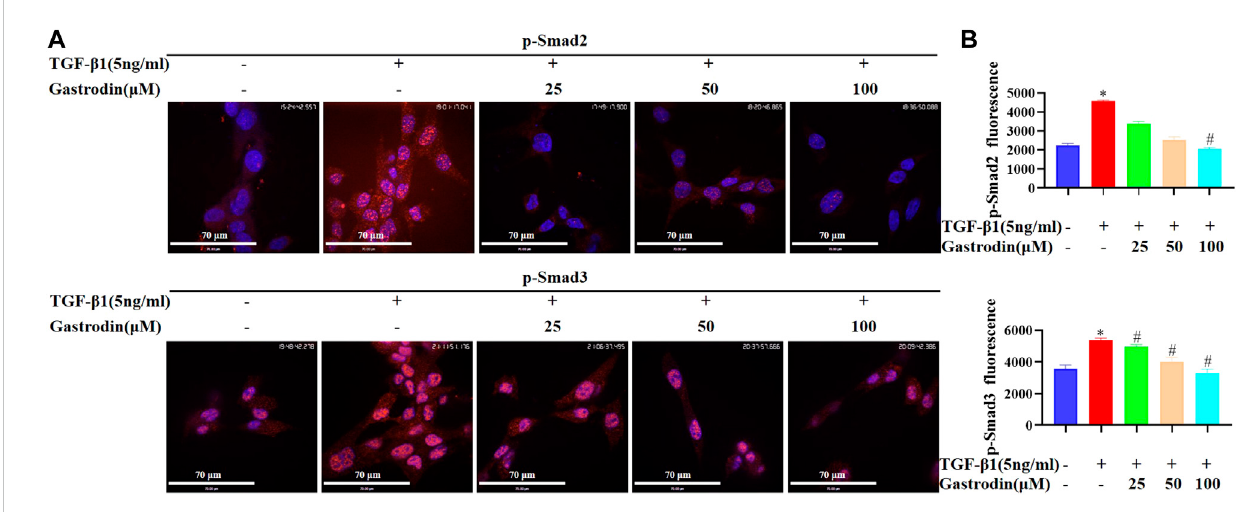
FIGURE 8 Gastrodin inhibited the TGF- β 1/Smad2/3 signaling pathway in vitro (A) Immuno fl uorescence (IF) staining was performed to detect the expressions of p-Smad2 (p-Smad2)and p-Smad3 (p-Smad3) (red). Nuclei (blue) were stained with Hoechst. Magni fi cation, ×600 (scale bar 70 μ m) (B) Relative p-Smad2 and p-Smad3 expressions in each group were determined using ImageJ. All values are mean ± SD ( n = 3 for each group). * p < 0.05 vs the control group, # p < 0.05 vs the TGF- β 1